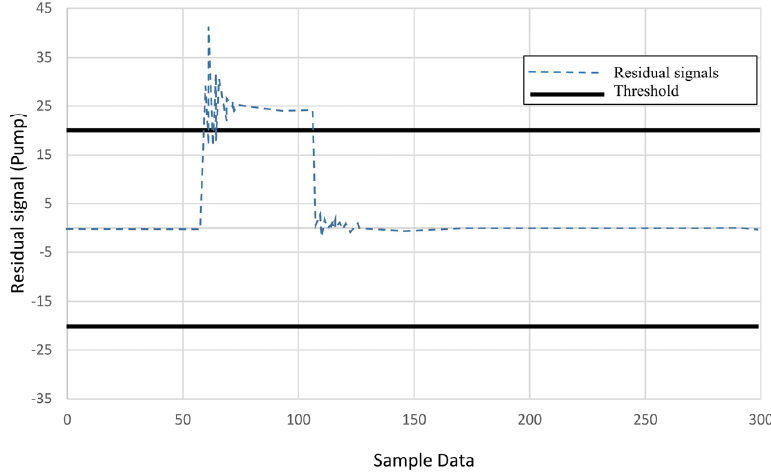
Figure 7. The pump signal for the pipe under fault condition.